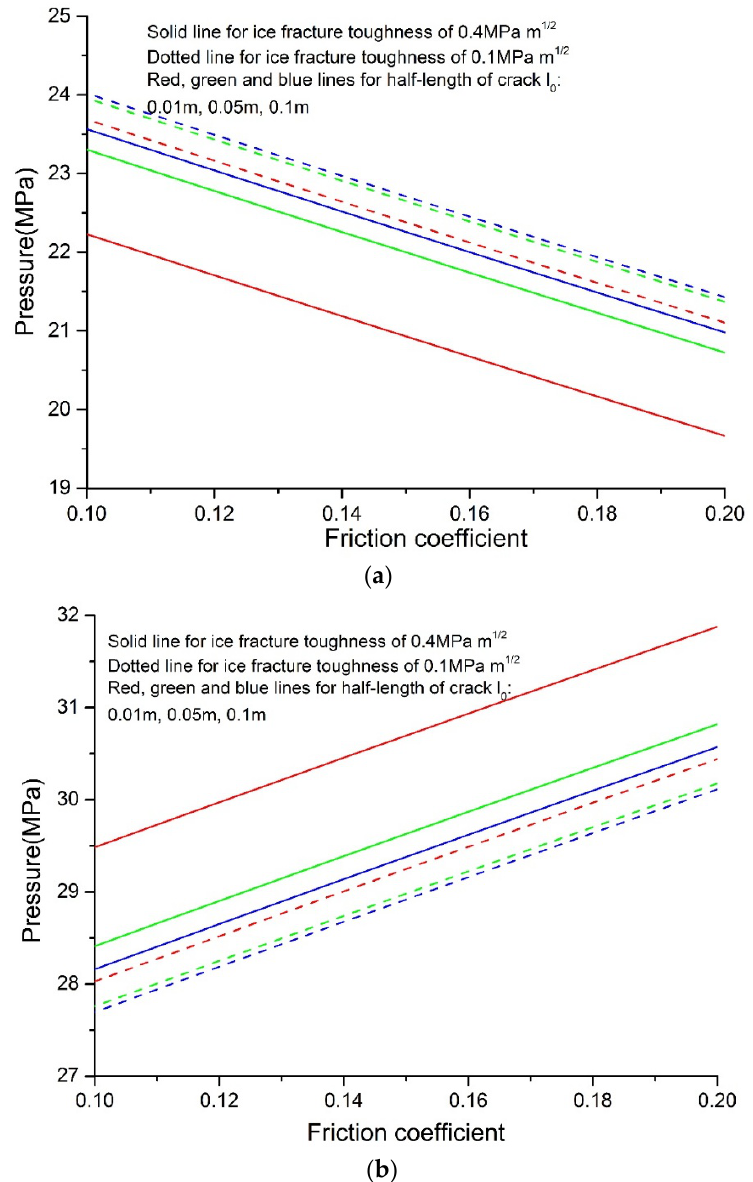
Figure 9. Critical borehole pressure changes for a fissured ice borehole wall at depth of 3000 m. ( a ) Borehole collapse; ( b ) borehole fracturing.